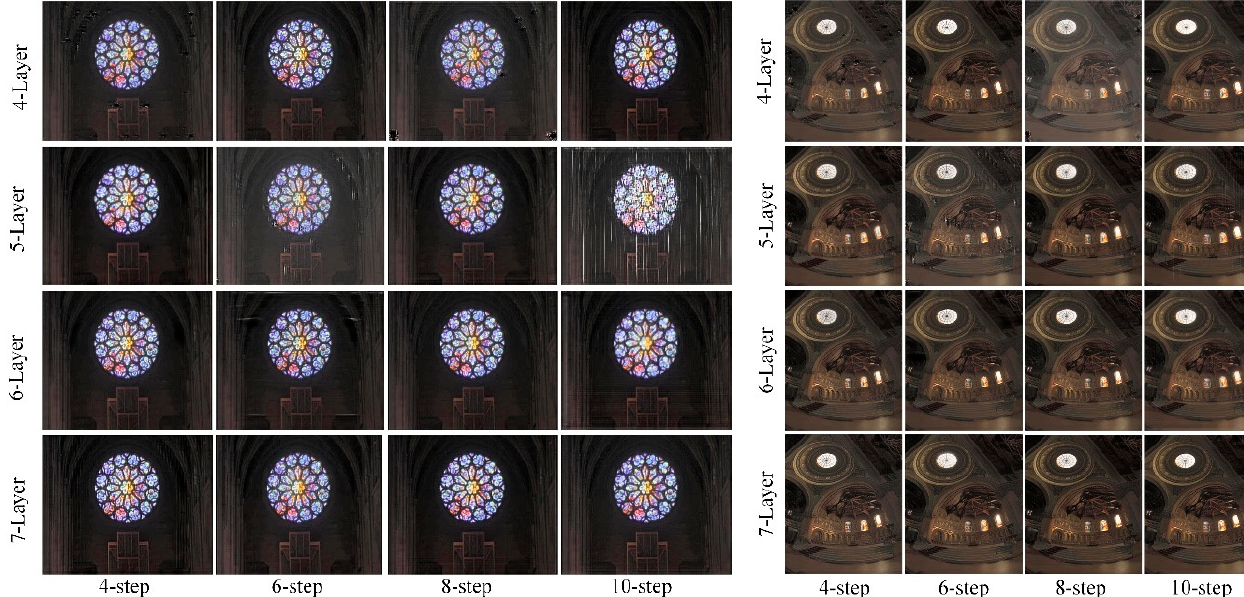
( d ) Figure 21. Metric scores for parameter optimization: ( a ) perception-based image quality evaluator, ( b ) multiscale structural similarity, ( c ) HDR-VDP2 quality, and ( d ) HDR-VDP2 visibility.